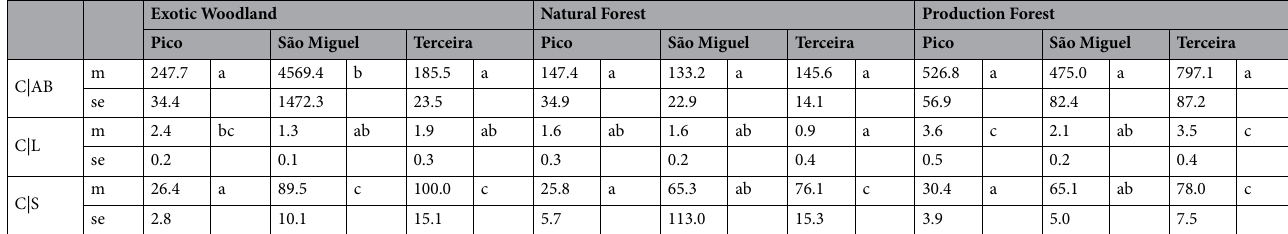
Table 7. Carbon stock found at 90 forests in the Azores, from three islands (Pico, São Miguel, and Terceira) and three forest types (Exotic Woodland, Natural Forest, and Production Forest). Mean and standard error for each structural parameter. Carbon stock in the trees, both above and below ground (C|AB, Mg ha −1 ), in leaf litter (C|L, Mg ha −1 ), and in soil (C|S, Mg ha −1 ). For each row, different letters indicate significant differences (p < 0.05) according to the results of a Tukey test applied after